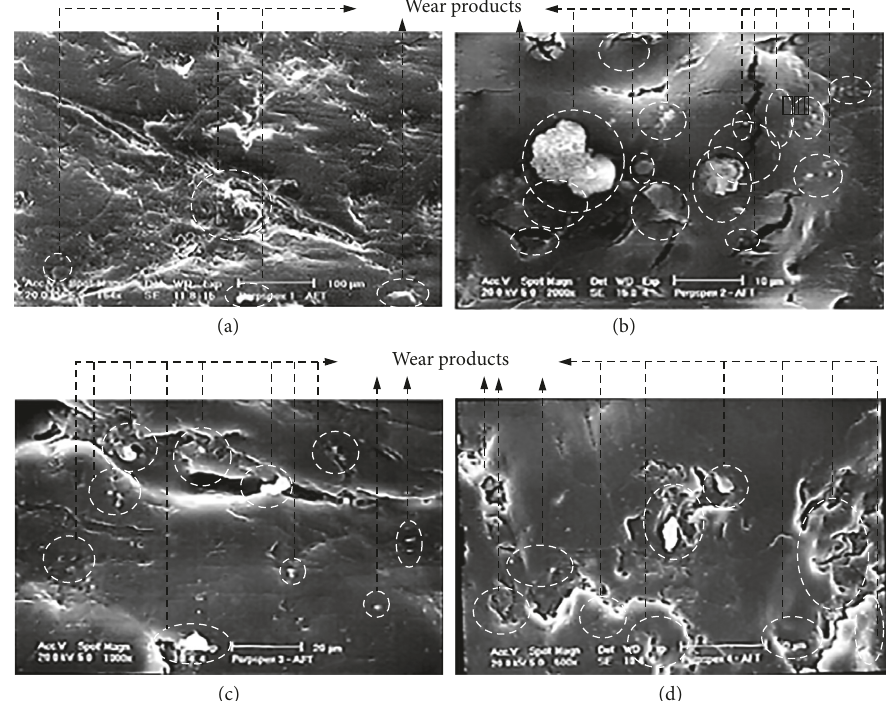
Figure 4: Photoelectron micrographs for the four PMMA surfaces rubbed alongside the three shoes after the dynamic friction tests (ADFT): (a) PMMA1, (b) PMMA2, (c) PMMA3, and (d) PMMA4.